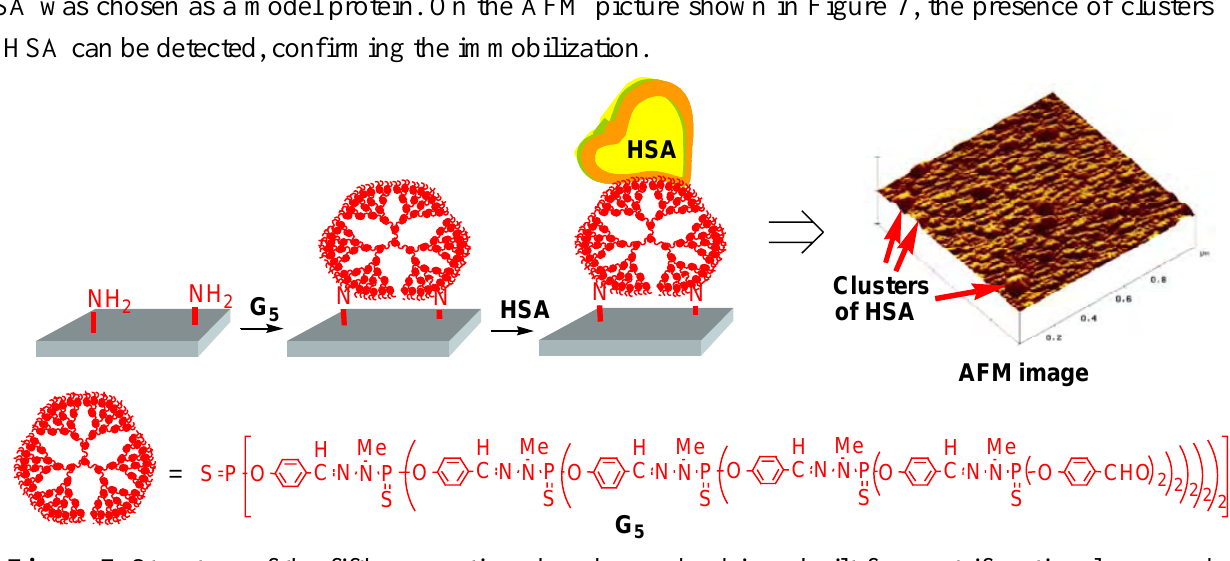
groups, and the 2